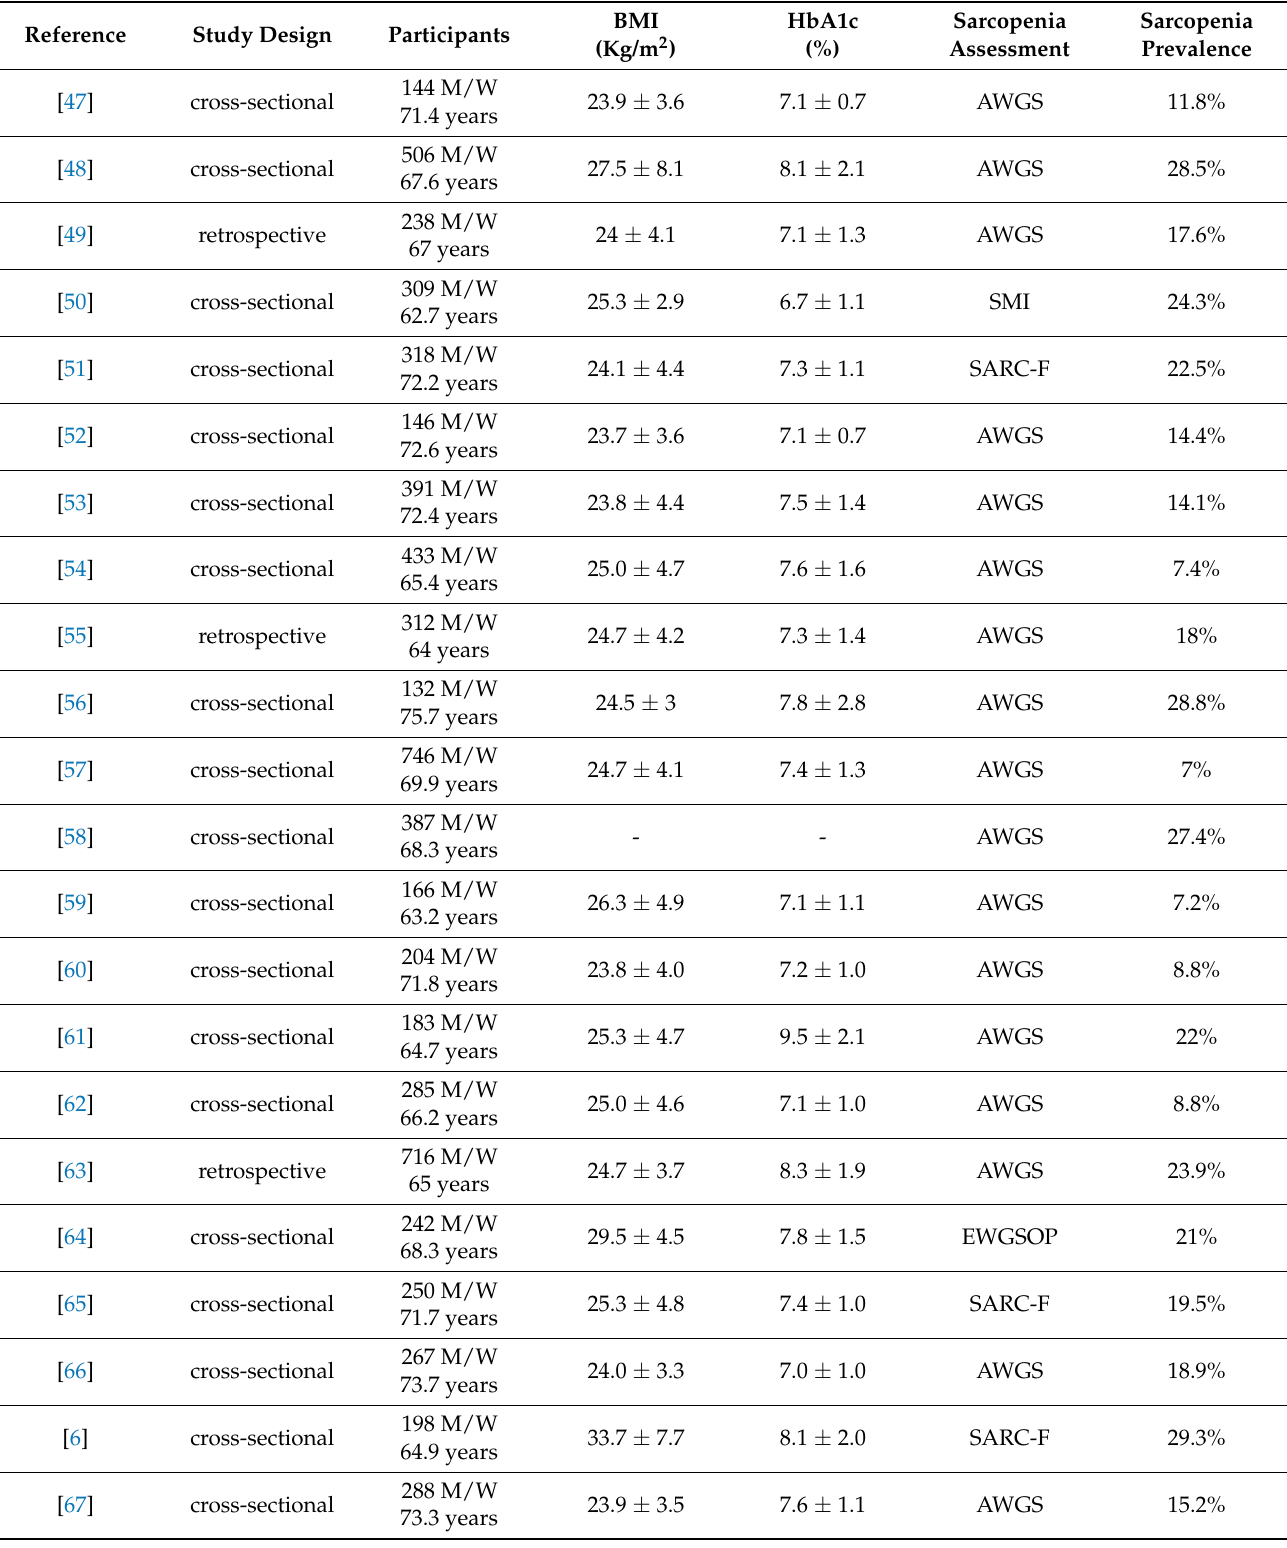
BMI: body mass index; HbA1c: glycated hemoglobin A1c; M: men; W: women; AWGS: Asian Working Group for Sarcopenia; SMI: skeletal muscle index; SARC-F: sluggishness, assistance in walking, rising from a chair, climb stairs, falls; -: data not available; EWGSOP: European Working Group on Sarcopenia in Older